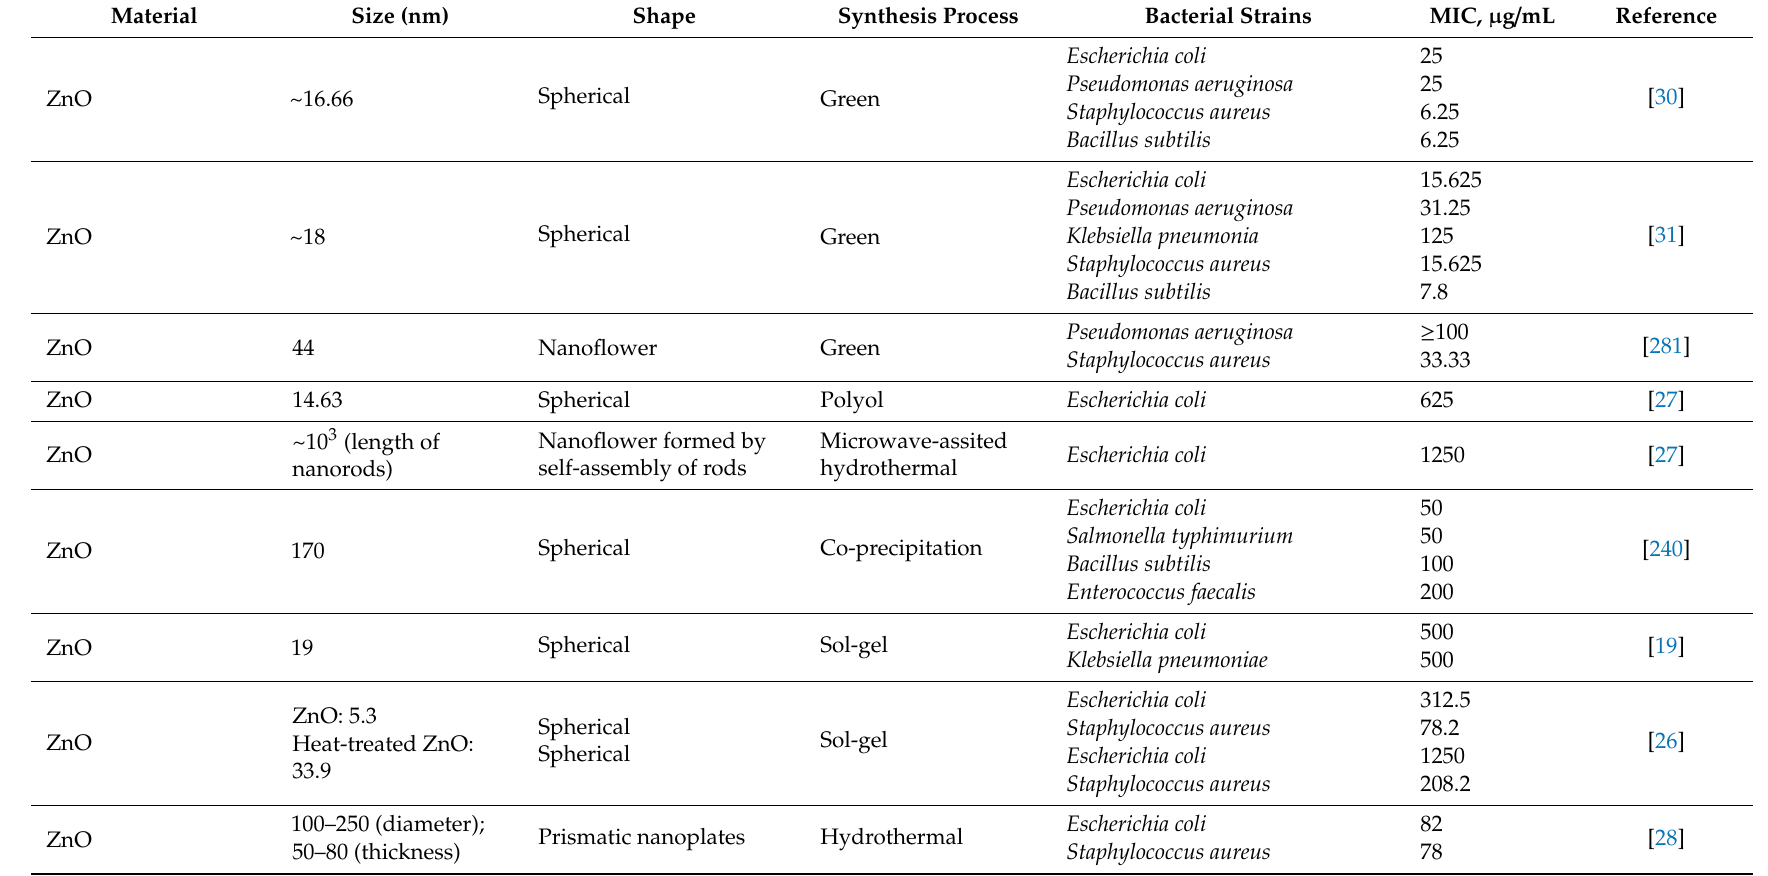
Table 1. Minimal inhibitory concentration (MIC) of ZnO nanostructures prepared by di ff erent